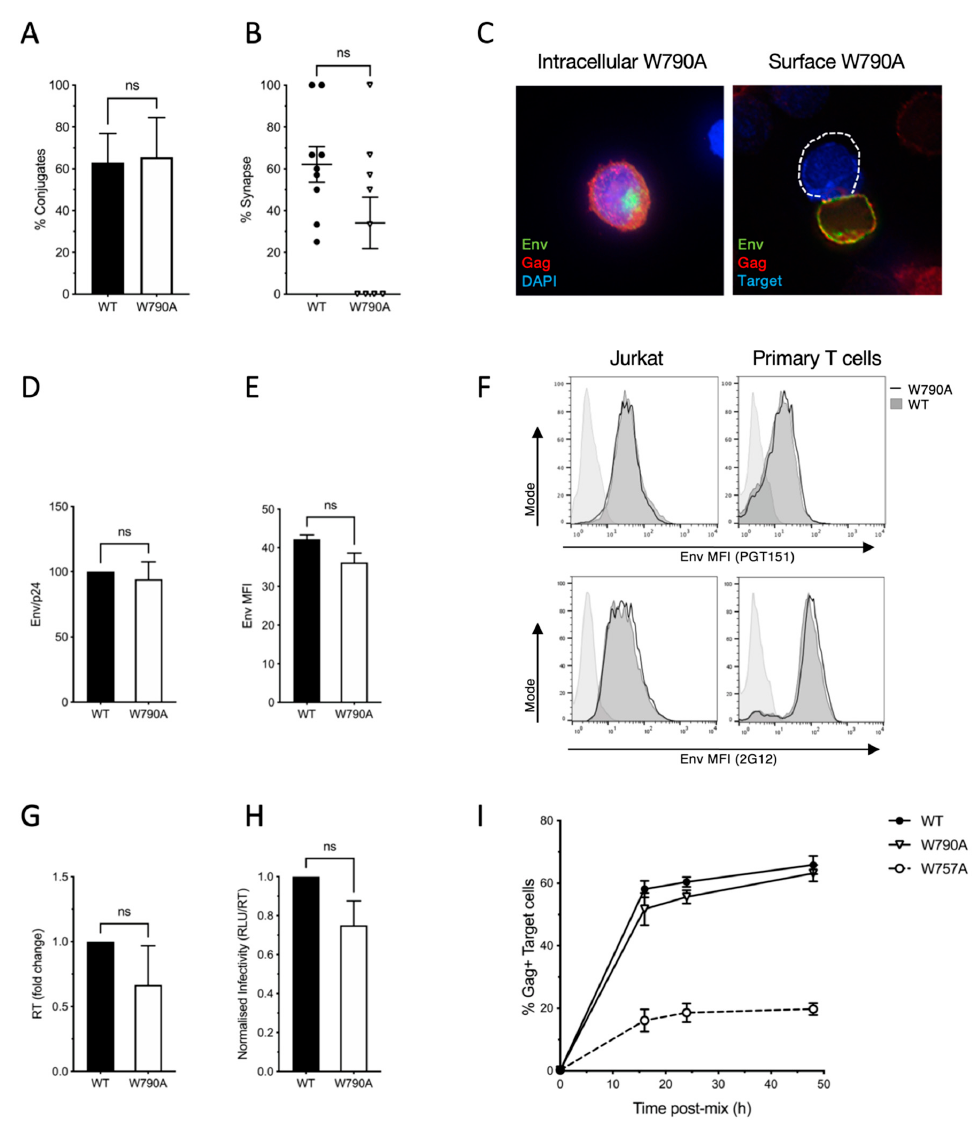
Figure 2. EnvCT W790A virus does not perturb HIV-1 Env function and viral cell–cell spread. ( A ) Alanine substitution of the tryptophan at HIV-1 envelope position 790 does not affect the ability of infected Jurkat cells to form conjugates with uninfected target cells. ( B , C ) EnvCT W790A-infected cells also form synapses to the same extent as WT HIV-1 do and result in no defect in both intracellular and surface localization of Env. ( D ) Quantification of Env (gp120) incorporation into virions produced in Jurkat cells, normalised to Gag (p24) density. ( E ) Quantification of surface Env MFI in infected Jurkat cells measured by flow cytometry analysis of cells stained with bNab PGT151. ( F ) Cell surface W790A Env staining (solid black line, unfilled) and WT virus (dark grey, filled) measured by flow cytometry staining using bNab PGT151 (top) or 2G12 (bottom). Uninfected control is shown as a light grey-filled histogram. ( G , H ) Budding of W790A virions from infected cells ( G ), and the relative infectivity ( H ) of W790A virus is equivalent to that of WT. ( I ) Spreading infection of W790A virus between Jurkat T cells over time (measured by flow cytometry analysis of the percentage Gag+ cells) is equivalent to that of WT virus, but is defective for W757A